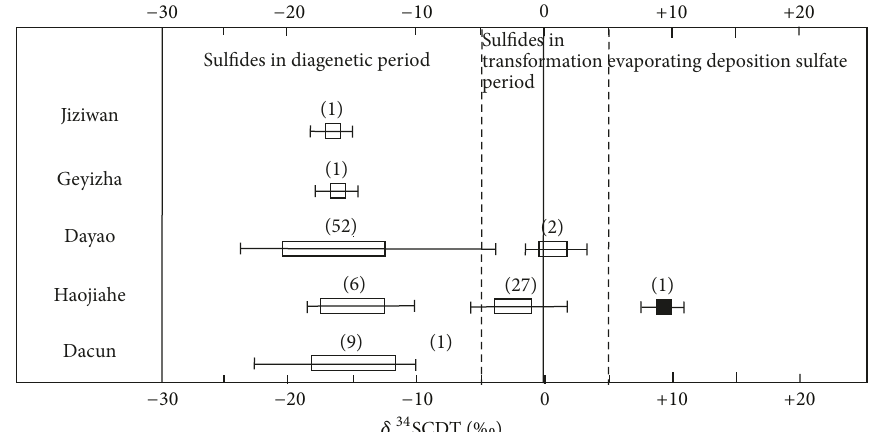
Figure 10: Distribution of sulfur isotope compositions for sulfides from the red-bed type copper deposits in Chuxiong basin. Sources of data are as follows: [51, 70–75]. The number of parentheses is the number of